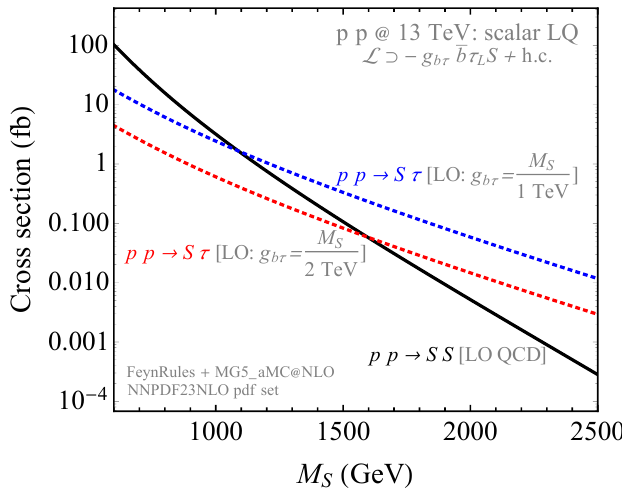
Figure 7 . Cross section (in fb) at 13 TeV pp collider for: (a) scalar LQ pair production (solid black line), and (b) single LQ + (cid:28) production for the two coupling benchmarks motivated by the (cid:12)t to low-energy data (dashed blue and red